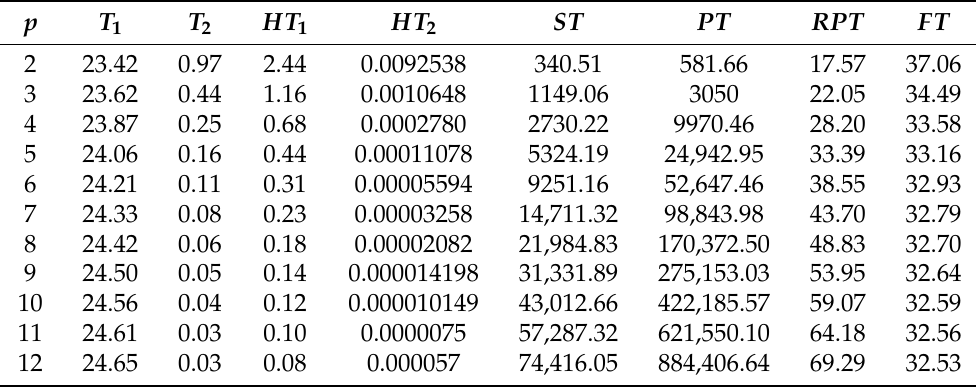
Table 2. Temperature indices of silicate network SN p for p ≥